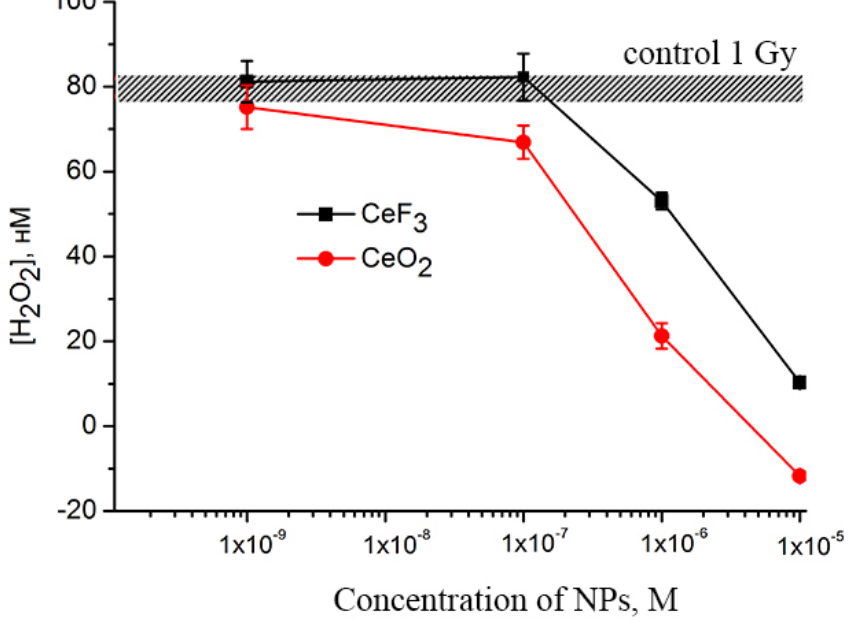
Figure 2. Concentration dependencies of hydrogen peroxide formation induced by X-ray irradiation (1 Gy) in a buffer solution containing CeF 3 and CeO 2 NPs. The mean values of three independent experiments and their standard errors are given.